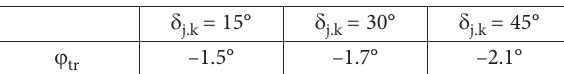
Table 2. Trim angles for adjustable-incidence tailplane